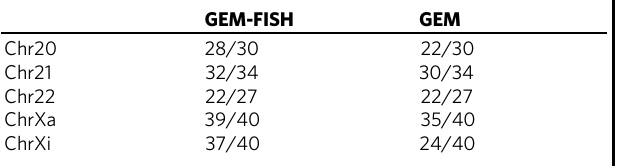
The tableentries are fi lledwith the format of “ number of correctly assigned TADs/total number ofTADs ” .InGEM,duetotheavailabilityofonlythenon-allele-speci fi cHi-Cmaps(whichdonot distinguish between ChrXa and ChrXi) for the IMR90 cell line 8 , we only considered one 3D model for ChrX